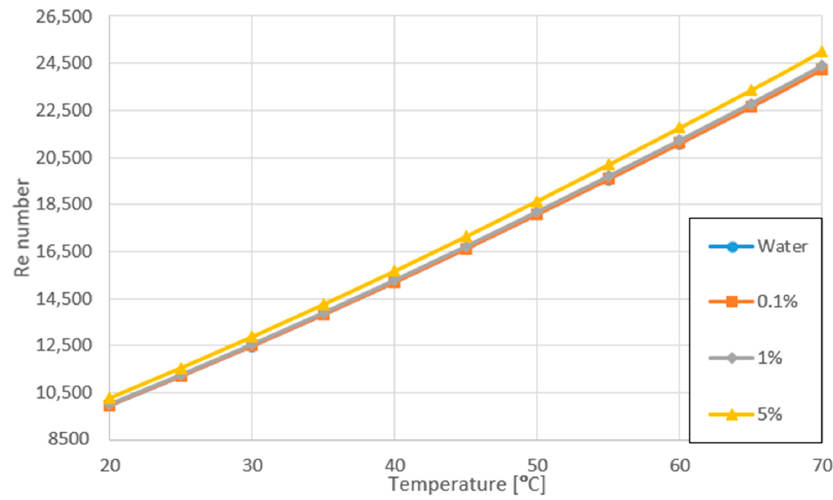
Figure 15. Variation of Re number for water-Al 2 O 3 nanofluids.